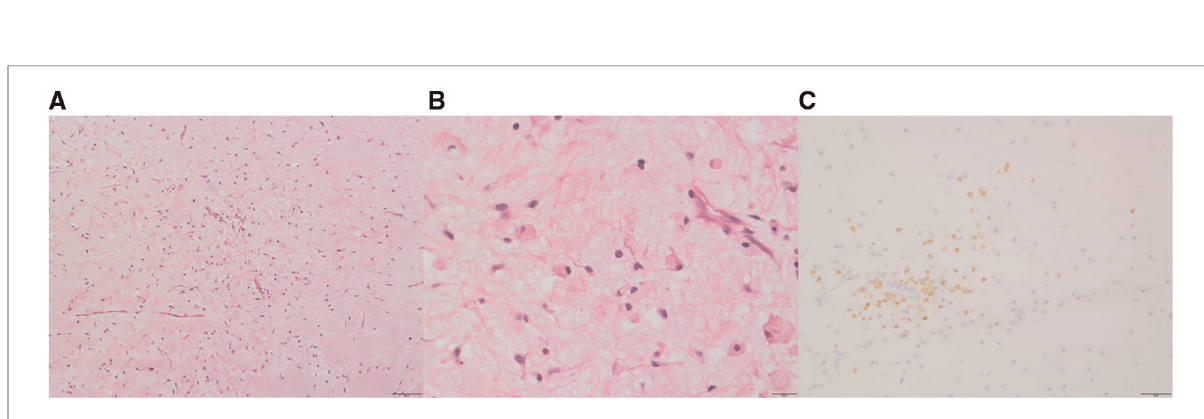
FIGURE 2 After the fi rst surgery, hematoxylin and eosin staining of aggressive angiomyxoma (AAM): short spindle cells are seen on a mucous background, showing invasive growth ( A :10×, B : 40×); in immunohistochemistry, S-100 was positive ( C